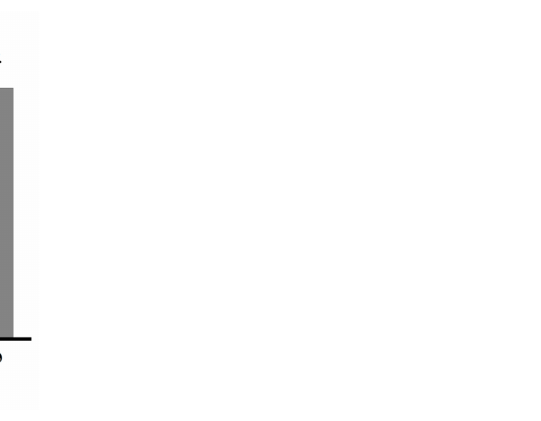
Figure 5. Effect of 200 ng dsRNA of four Genes on mortality of E. oblique . Three replicates per treatment. Each bar represents the mean ± SD. Different letters indicate significant differences ( p < 0.05) by using a Tukey test to compare in ANOVA.